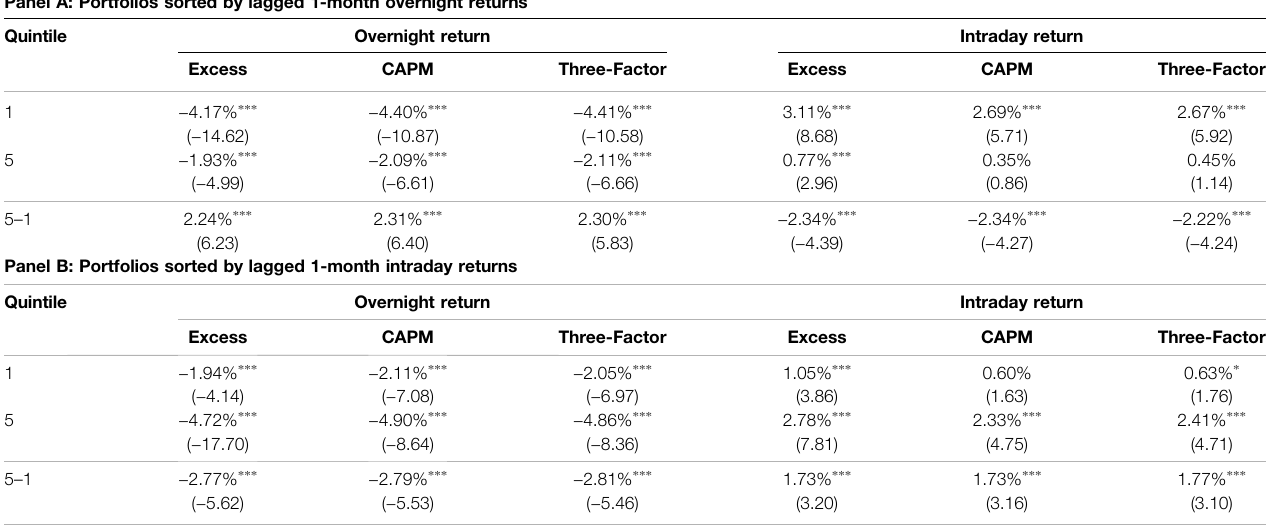
Panel A: Portfolios sorted by lagged 1-month overnight